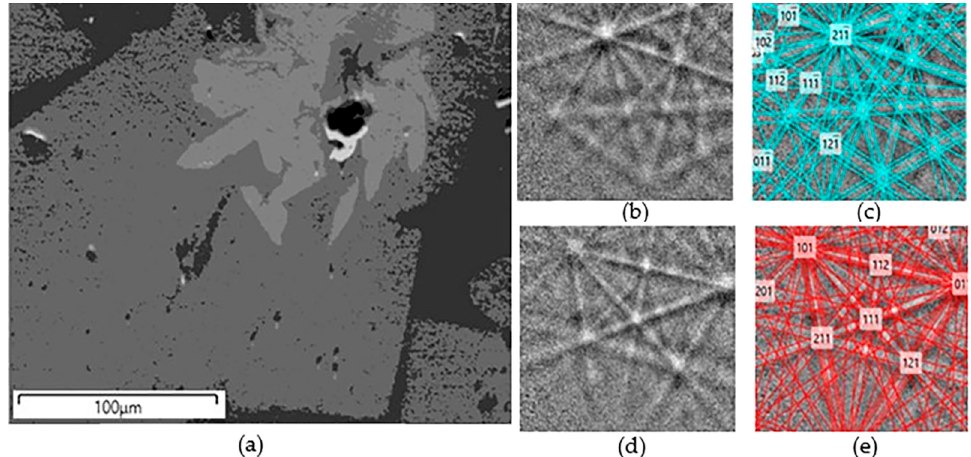
Figure 8. ( a ) SEM image of the analysed area, light—zirconolite, gray and dark-gray—murataite, and EBSD patterns of ( b , c ) zirconolite and ( d , e ) murataite, ( b , d ) before and ( c , e ) after indexing. 5.2. Pyrochlore—Zirconolite Ceramic with Neodymium (Sample “Nd”) The sample “Nd” studied by the EBSD method was prepared by melting for 0.5 h at 1500 ◦ C in a glassy carbon crucible. Its composition as well as spots of other samples (S3–S5, S8) are shown in Figure 9a. For ease of plotting, NdO 1.5 , TiO 2 , and ZrO 2 are located at the vertices of the triangular diagram [143]. The composition, mol % 35 NdO 1.5 , 13 Nd 2 O 3 , 52 ZrO 2 (or 21 Nd 2 O 3 , 16 ZrO 2 , 63 TiO 2 ) corresponds to the association of pyrochlore Nd 2 (Zr,Ti) 2 O 7 and srilankite ZrTiO 4 . Nevertheless, the X-ray diffraction pattern showed